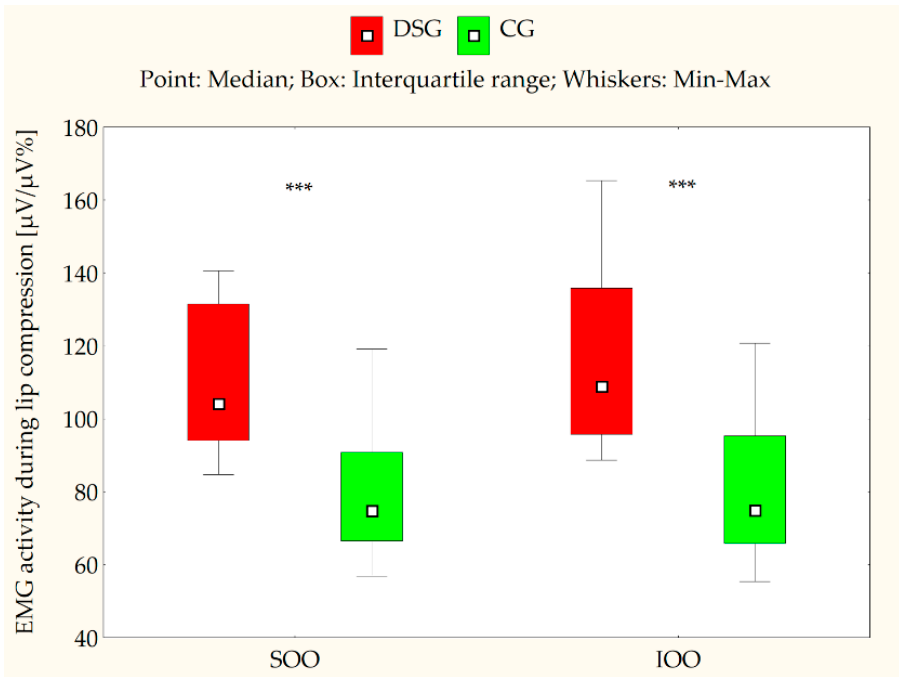
Figure 3. EMG activity of the superior orbicularis oris (SOO) and inferior orbicularis oris (IOO) muscles (µV/µV%) during lip compression in the Down syndrome group (DSG) and the control group (CG); *** p < 0.001.